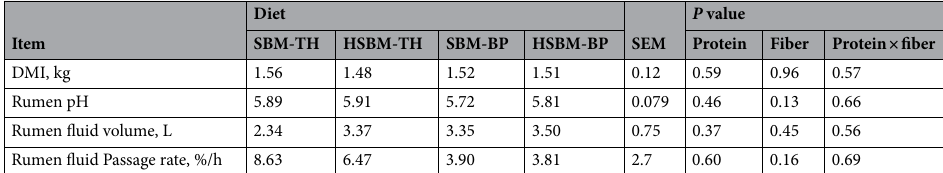
Table 2. LS means for DMI and rumen variables as differentiated by diet along with P values for the effects of protein source, fiber source, and the interaction of protein and fiber source a . a HSBM-TH heat-treated soybean meal and timothy hay, SBM-TH soybean meal and timothy hay, HSBM-BP heat-treated soybean meal and beet pulp, SBM-BP heat-treated soybean meal and beet pulp.